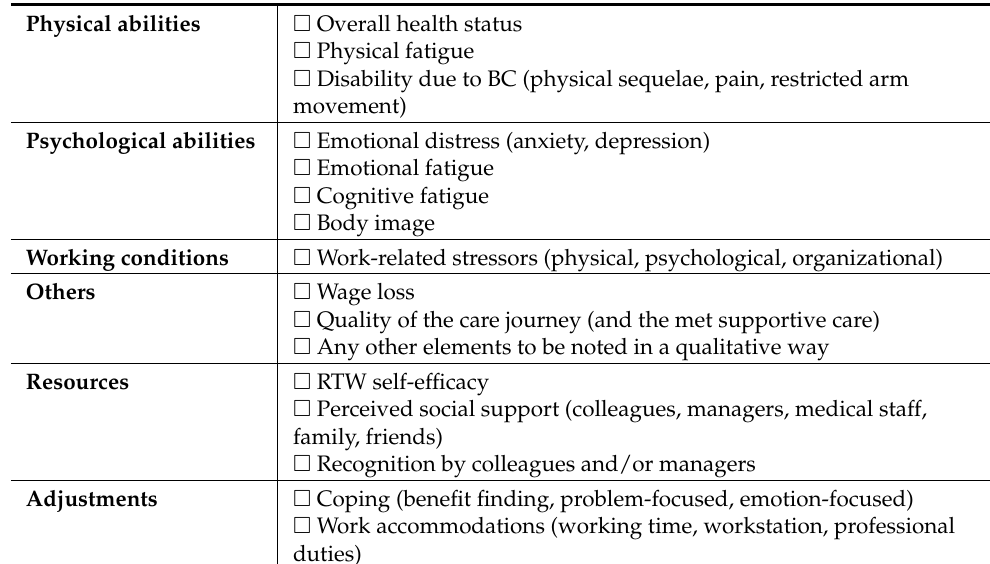
Table 4. Reminder of the variables to be recorded at the preparation